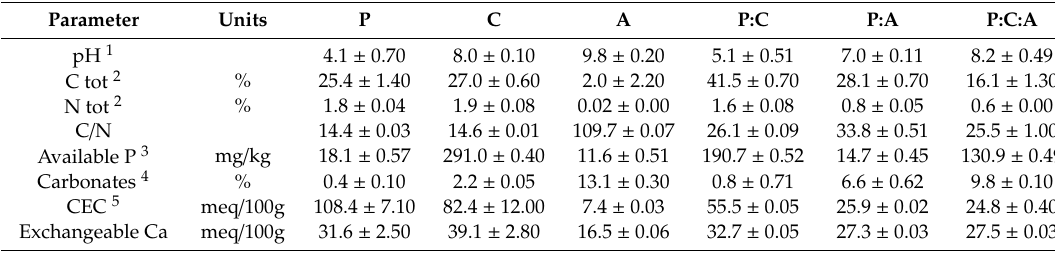
Table 1. Physical properties, chemical properties and heavy metal content of raw materials (P = peat; C = compost; A = demolition aggregates) and mixtures tested as cultivation substrates (P:C = peat and green compost, 70%:30% v / v ; P:A = peat and demolition aggregates, 70%:30% v / v ; P:C:A = peat, green compost and demolition aggregates, 40%:30%:30% v / v ) with standard